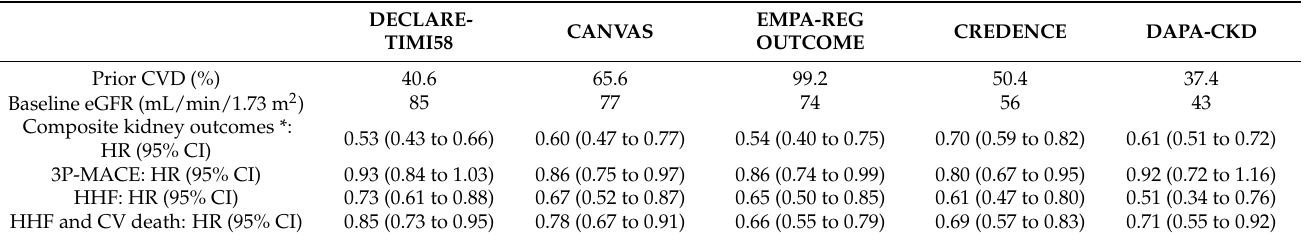
Table 2. Baseline characteristics and cardio-renal outcomes of the enrolled patients in each study. EMPA-REG DECLARE- CANVAS OUTCOME TIMI58